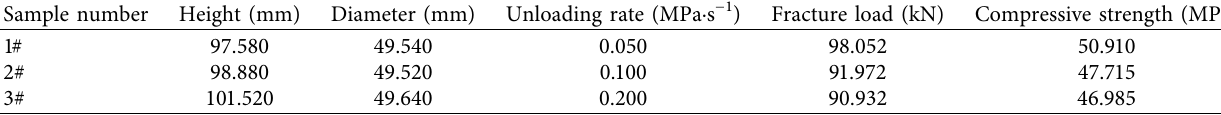
Table 2: Unloading test results at different rates.